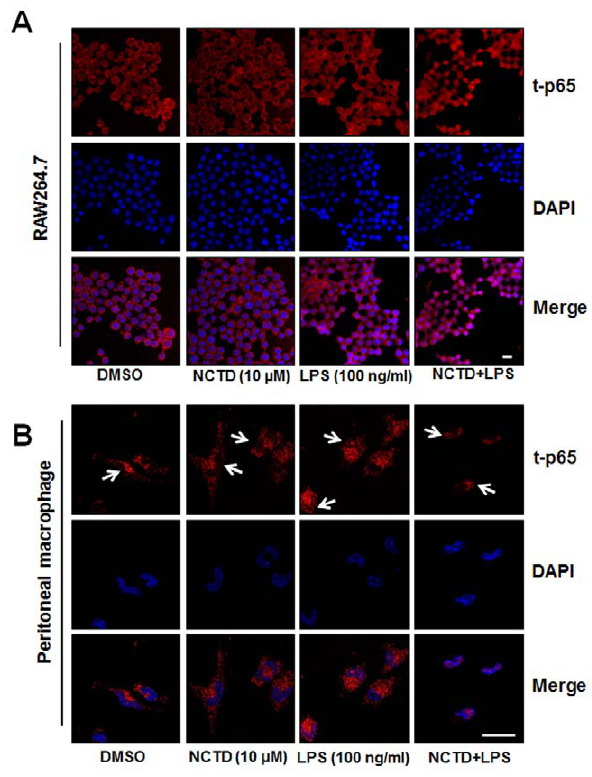
Figure 6. NCTD facilitates NF- k B nuclear translocation. A–B, RAW264.7 cells (A) and peritoneal macrophages (B) were stimulated with 100 ng/ml LPS in absence or presence of 5 m M NCTD that had been added 24 h before. When LPS addition was added for 15 min, subcellular location of NF- k B p65 subunit was detected using immunofluorescence assay. Scale bar, 10 m m. One of three experiments was shown.